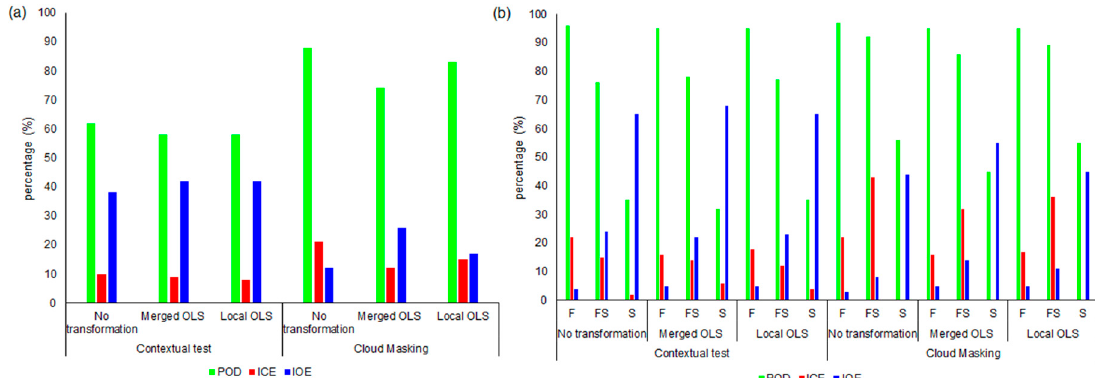
Figure 11. ( a ) Percentage of probability of detection (POD), independent commission errors (ICE) and independent omission errors (IOE) of ToPeCAl-2 with contextual test and ToPeCAl-2 with cloud masking applied to Sentinel-2 images compared with fires resultant from ToPeCAl-1 applied to Landsat-8 images; ( b ) As per Figure ( a ) but showing the comparison of fire classes, i.e., flaming (F), smouldering (S), and mix of flaming and smouldering (FS). The Top of Atmosphere (TOA) reflectance used in ToPeCAl-2 were with no transformation values and with transformation values from the merged Ordinary least squares (OLS) model and local OLS model.